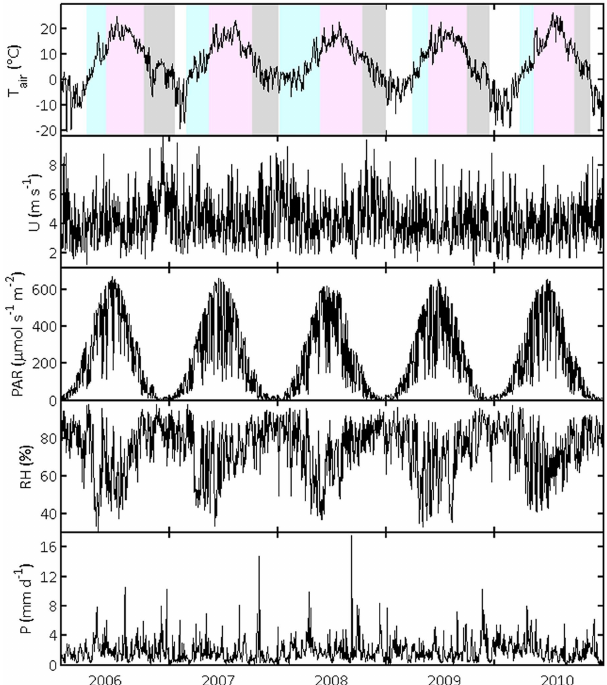
Fig. 2. Daily air temperature ( T air ) , wind speed ( U) , photosynthet- ically active radiation (PAR), relative humidity (RH) and precipita- tion ( P) during the five years of measurements. The colored areas in the upper panel show the thermal seasons: winter = white, spring = green, summer = red and grey =